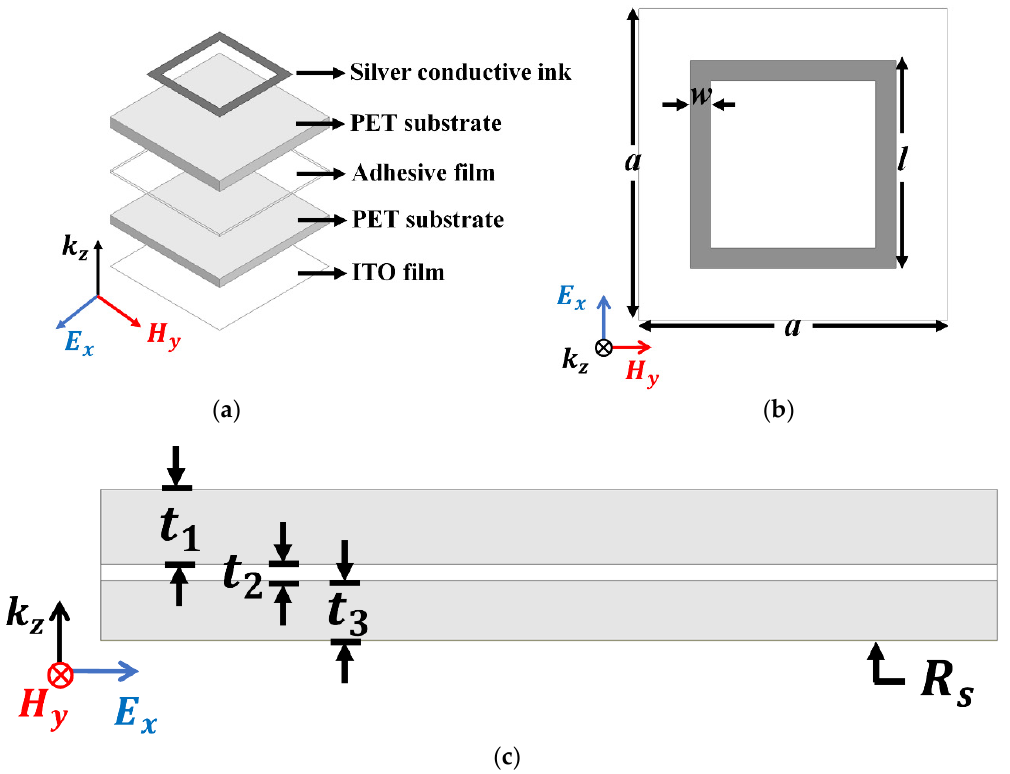
Figure 1. Geometry of the unit cell of the proposed absorber: ( a ) perspective, ( b ) top, and ( c ) side views of the unit cell.